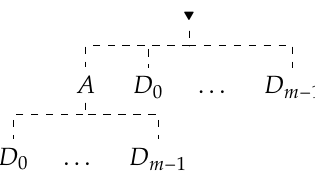
Figure 9. Proof of (T): the